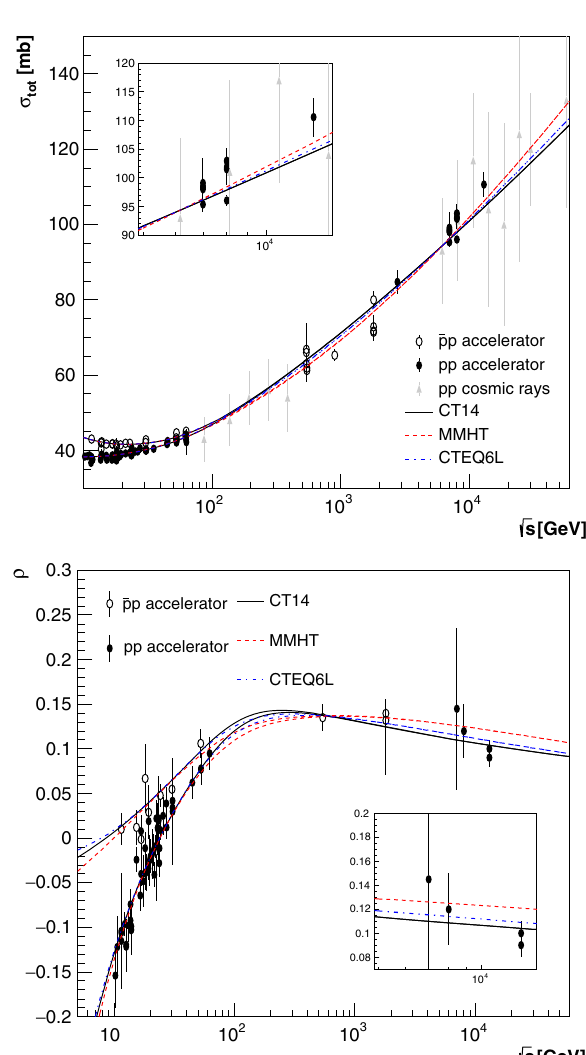
/ ¯ pp ρ pp / ¯ pp data taking ν 2 =0. Best fit tot and